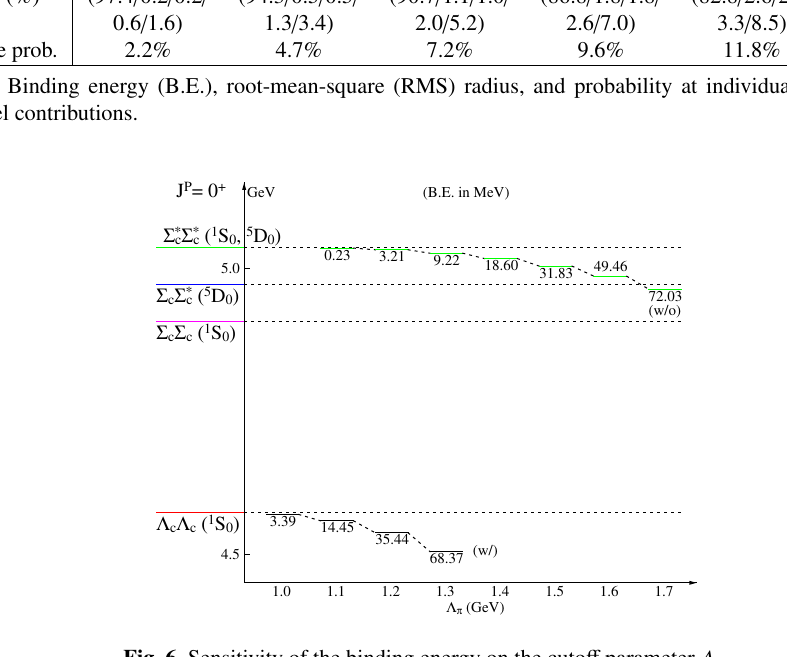
Fig. 6. Sensitivity of the binding energy on the cuto ff parameter Λ π